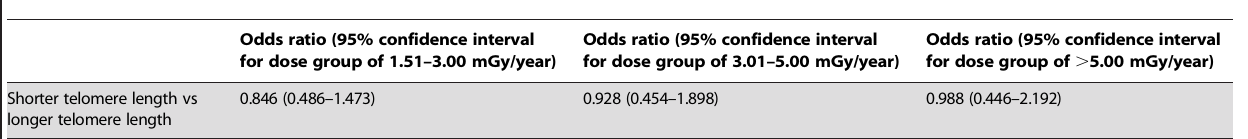
Table 2. Odds ratio and CIs of HLNRA and NLNRA adults according to telomere